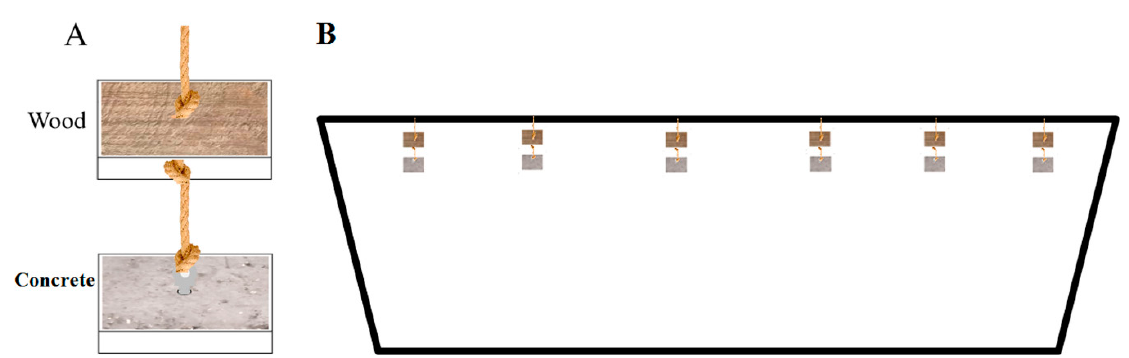
Figure 1. ( A ) Schematic diagram of a pair of concrete and wooden artificial reefs (AR) blocks; ( B ) vertical deployment of AR block array on the beam of a boat.